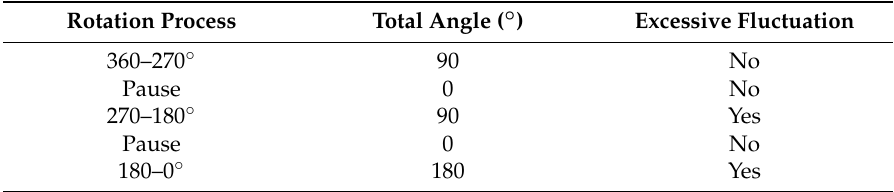
Table 1. Uniform rotation process of the outer gimbal for determining the regions with excessive temperature fluctuation of the temperature control system.